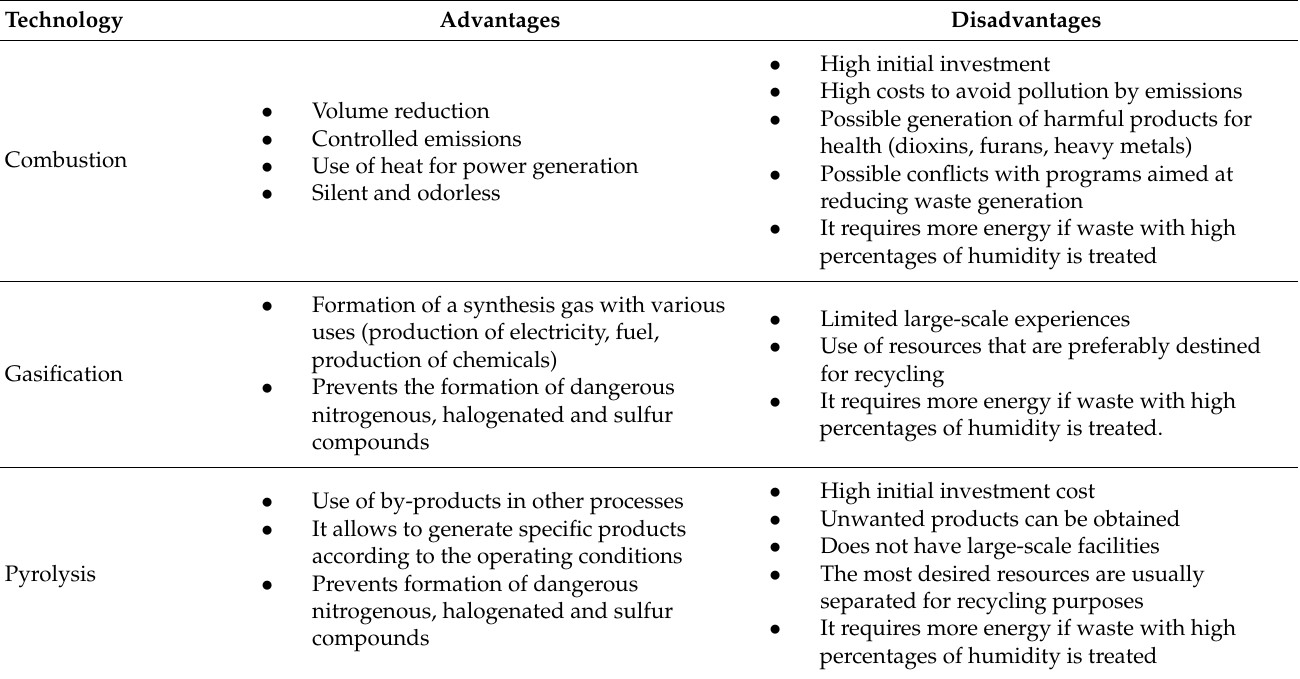
Table 3. Advantages and disadvantages of combustion, gasification and pyrolysis